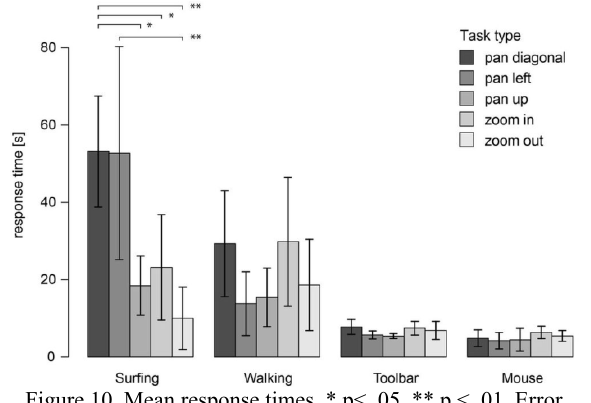
Figure 10. Mean response times. * p< .05, ** p < .01. Error bars indicate 95% confidence